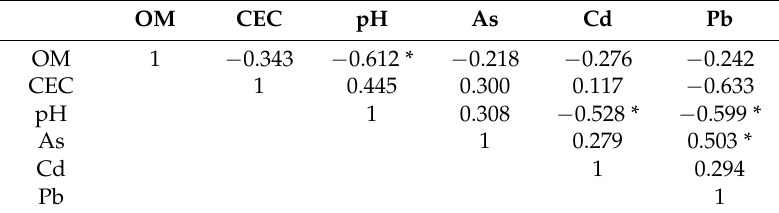
Table 4. Spearman rank correlation coefficients among soil parameters, As, Cd, and Pb, in 16 wheat grains. OM CEC pH As Cd Pb OM 1 − 0.343 − 0.612 * −